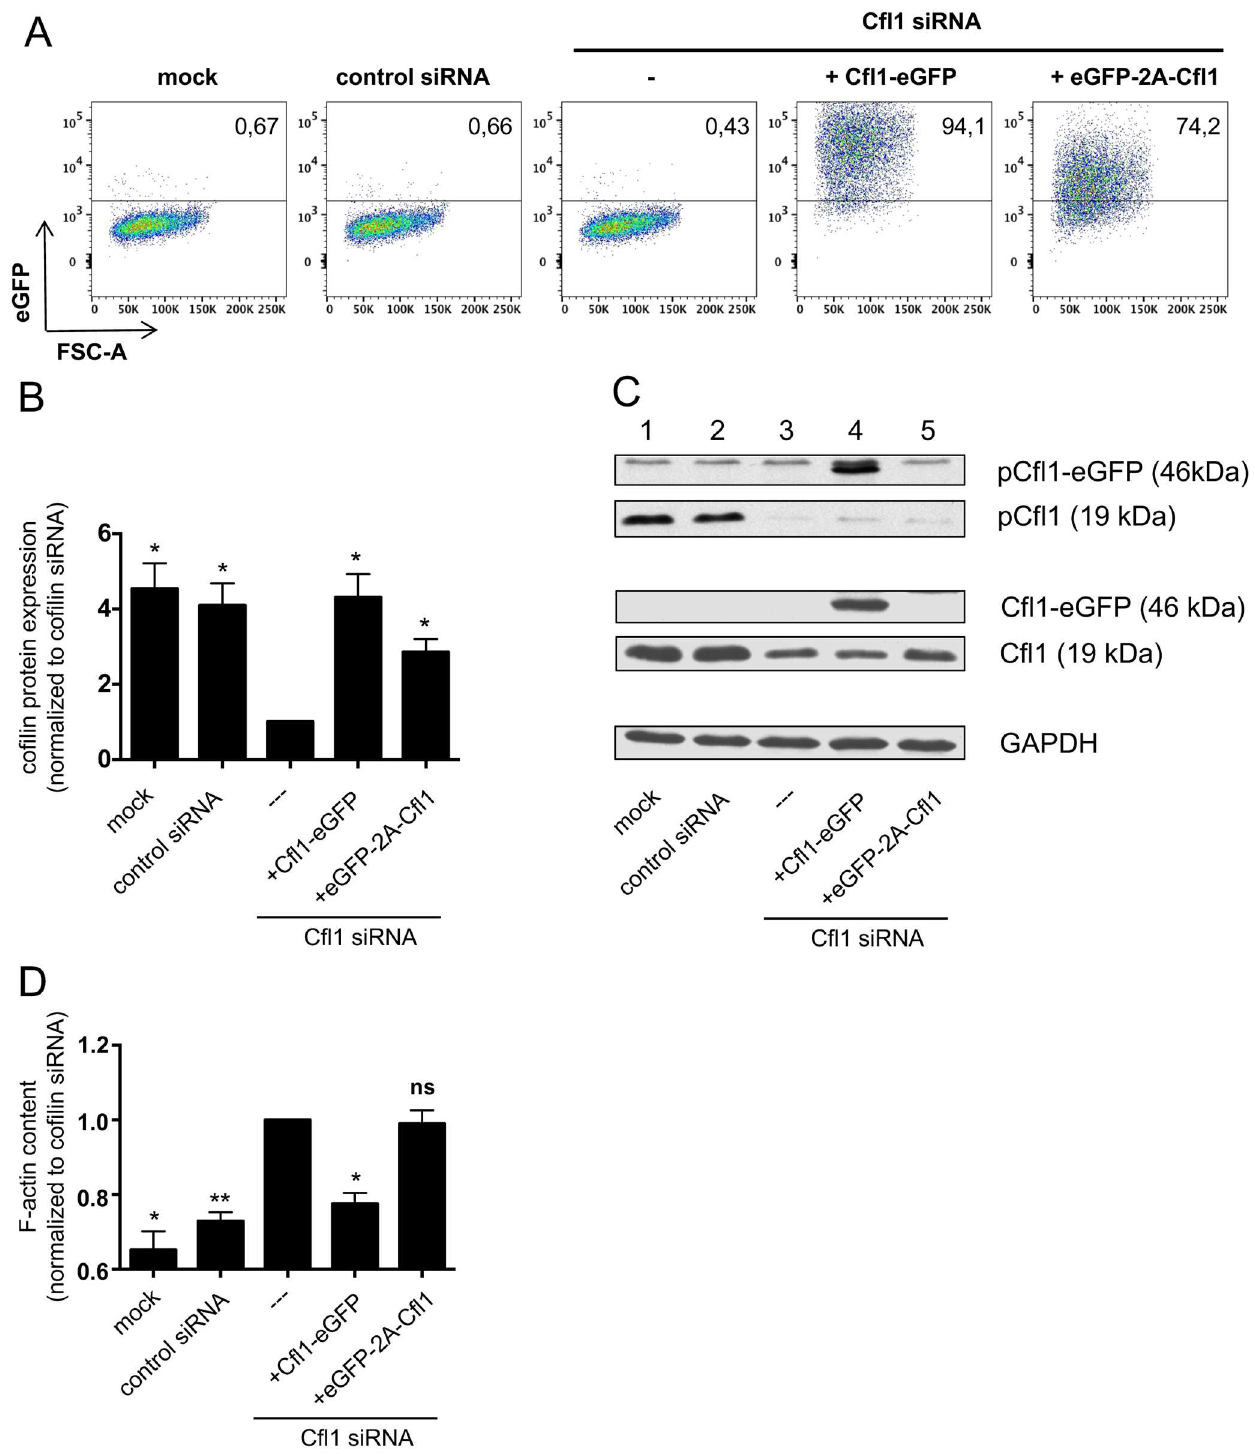
Fig 1. Cofilin expressed from an eGFP-2A-Cfl1 cassette is not functional in T-cells. Jurkat T cells were either transfected with no siRNA (mock), a nontargeting control siRNA or a cofilin-specific siRNA (binding to the 3 0 UTR), in order to downregulate endogenous cofilin. Some of the cells that received cofilin siRNA were cotransfected with Cfl1-eGFP control vector or a vector carrying the eGFP-2A-Cfl1 sequence under the control of the CMV promoter. Cells were harvested and analyzed 48 h after transfection. (A) Exemplary flow cytometric analysis of eGFP expression of transfected Jurkat cells ( n = 4 independent experiments). (B) Western blot analysis of total cell lysates by staining for total cofilin and GAPDH. All samples were normalized to cells